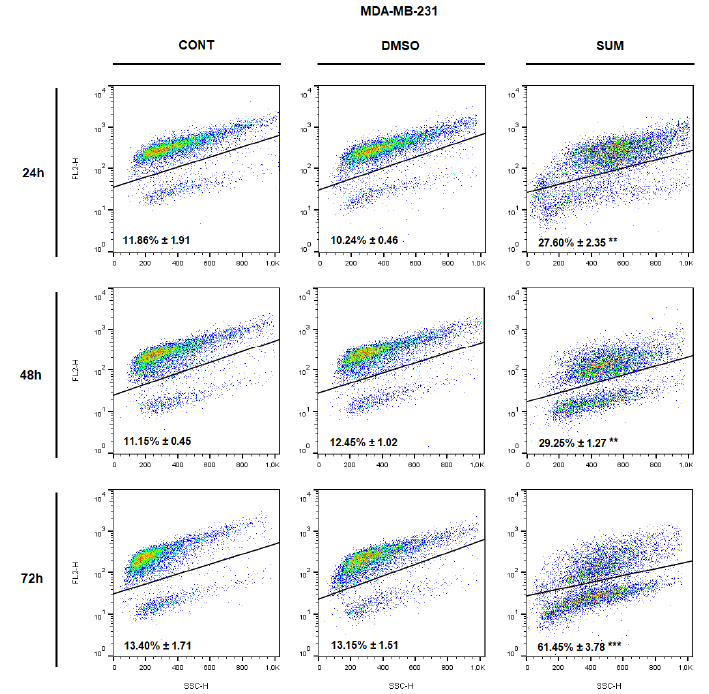
Figure 16. Mitochondrial membrane potential (MMP) changes in MDA-MB-231 cells after SUM (215 µg/mL) treatment. Data were obtained from three independent experiments. Significant